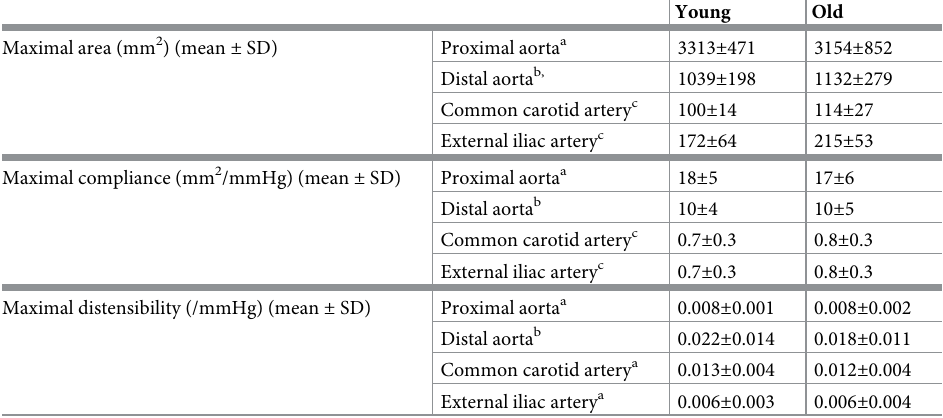
Table 2. Overview of mean maximal area, compliance and distensibility of the proximal aorta, distal aorta, com- mon carotid artery and external iliac artery.